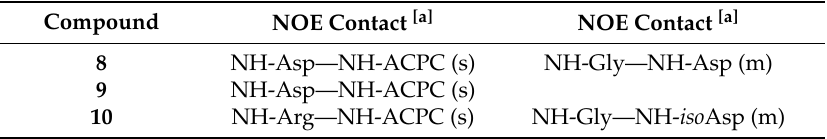
Table 4. Relevant long range NOE contacts for compounds 8–10